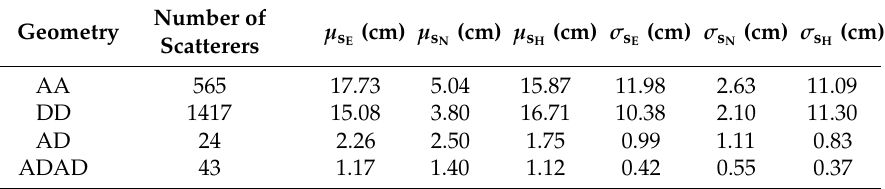
Table 3. Averaged statistics based on the stereo SAR least squares estimated 3D coordinate standard deviations in Oulu. The letters A and D stand for ascending and descending geometries, respectively. The sample mean and standard deviation are denoted by µ and σ and S [ ENH ] represents the local coordinates standard deviations within a 95% confidence level [89].